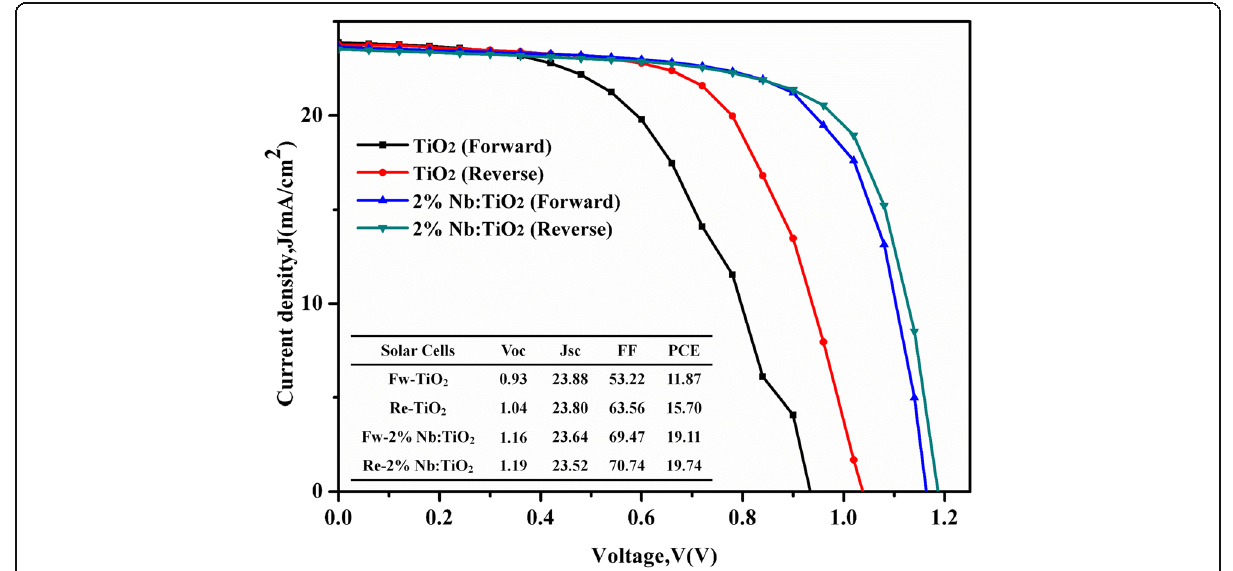
Fig. 7 The J-V hysteresis behavior of the PSCs based on bare TiO 2 and 2% Nb:TiO 2 layer under AM 1.5